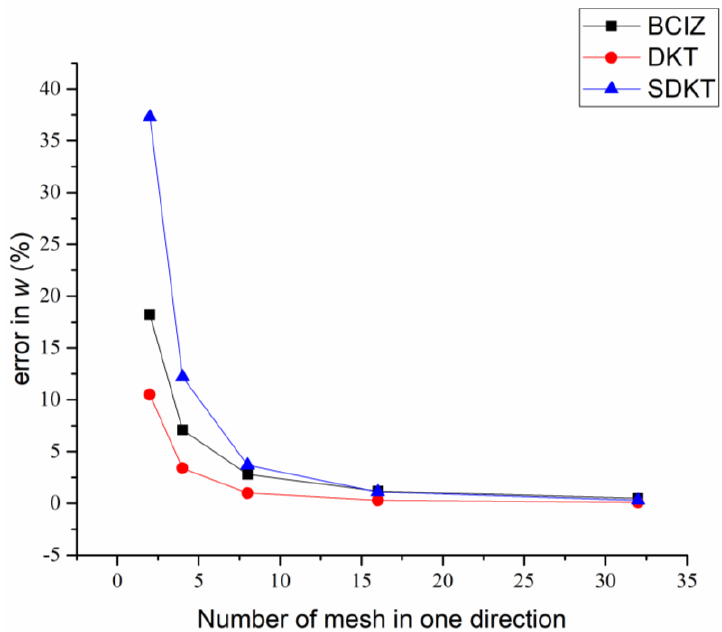
Figure 9. Error of the central deflection for a simply supported square plate under center point load.